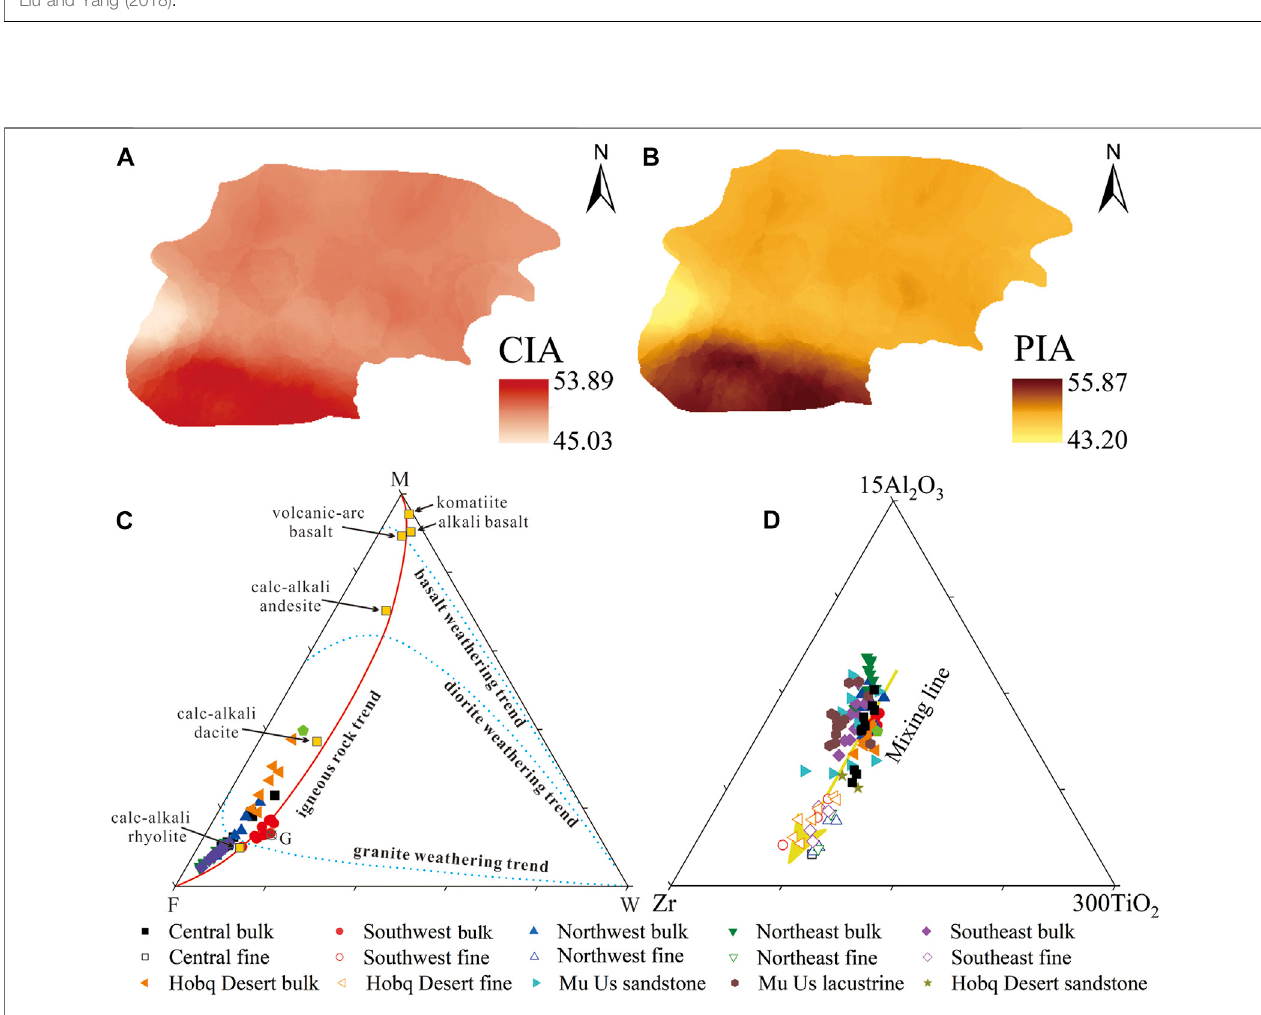
FIGURE 10 | Spatial patterns of CIA (A) and PIA (B) for sands in the Mu Us Sandy Land. Plots of MFW (Ma fi c-Felsic-Weathering) characterizing weathering trends (C) and Al-Zr-Ti diagram (D) for sediments in the Ordos Deserts. M and F denote the ma fi c and felsic rocks source, respectively, whereas the W used to identify the degree of weathering of these igneous rocks. Data of sandstone and lacustrine sediments in Mu Us and the Hobq Desert is from Liu and Yang (2018).